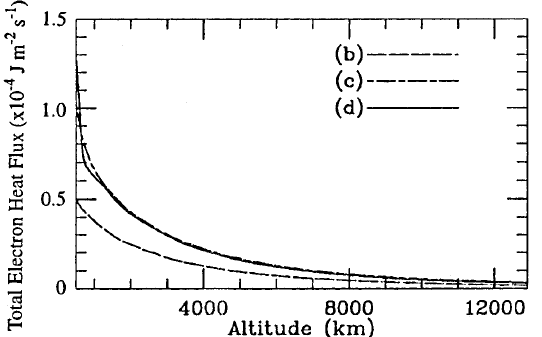
Fig. 13. Total heat flux profiles for the total electron population. The lines for cases (c) and (d) almost overlap in the plot. The labels correspond to the cases listed in Table 3